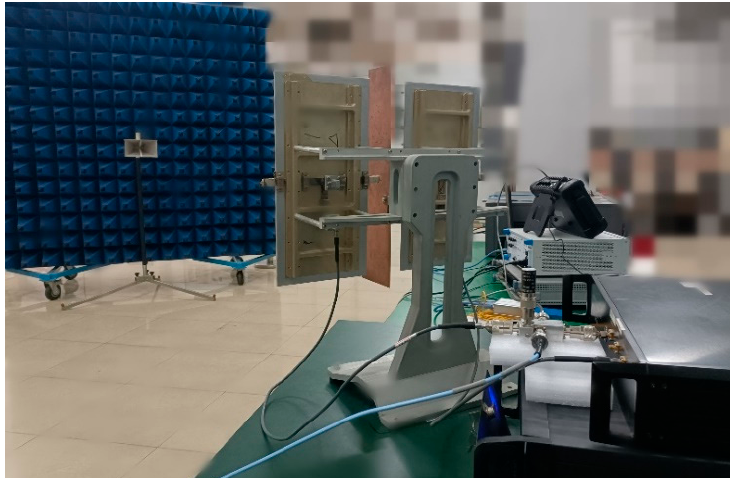
Figure 1. Block diagram of field configuration.